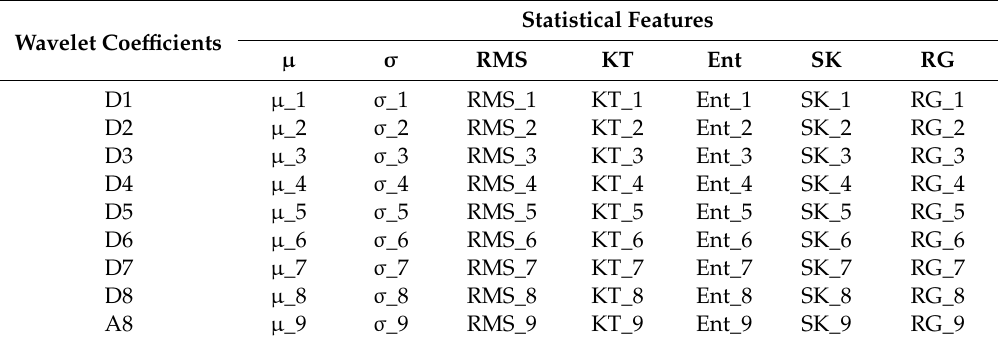
Table 1. Original feature set. Standard deviation ( σ ), mean ( µ ), root mean square (RMS), kurtosis (KT), entropy (Ent), skewness (SK) and range